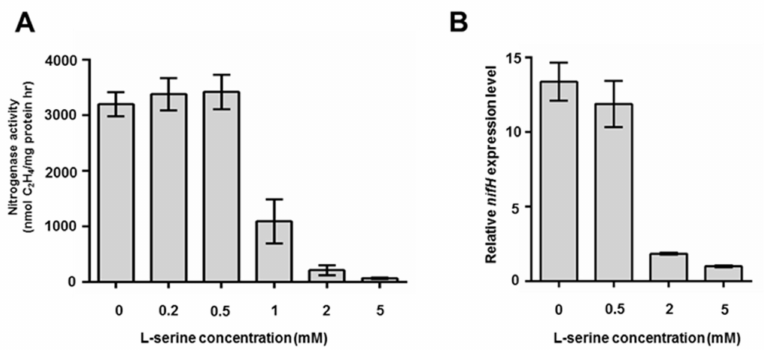
Figure 2. Nitrogenase activity and nifH expression of P. polymyxa WLY78 grown in different con- centrations of serine. ( A ) The nitrogenase activity of P. polymyxa WLY78 grown in nitrogen-limited medium containing 0-5 mM L-serine. ( B ) The nifH expression level of P. polymyxa WLY78 grown in nitrogen-limited medium containing 0-5 mM L-serine determined by qRT-PCR. Results are represen- tative of at least three independent experiments, mean values ± SDs were calculated from three sets of independent